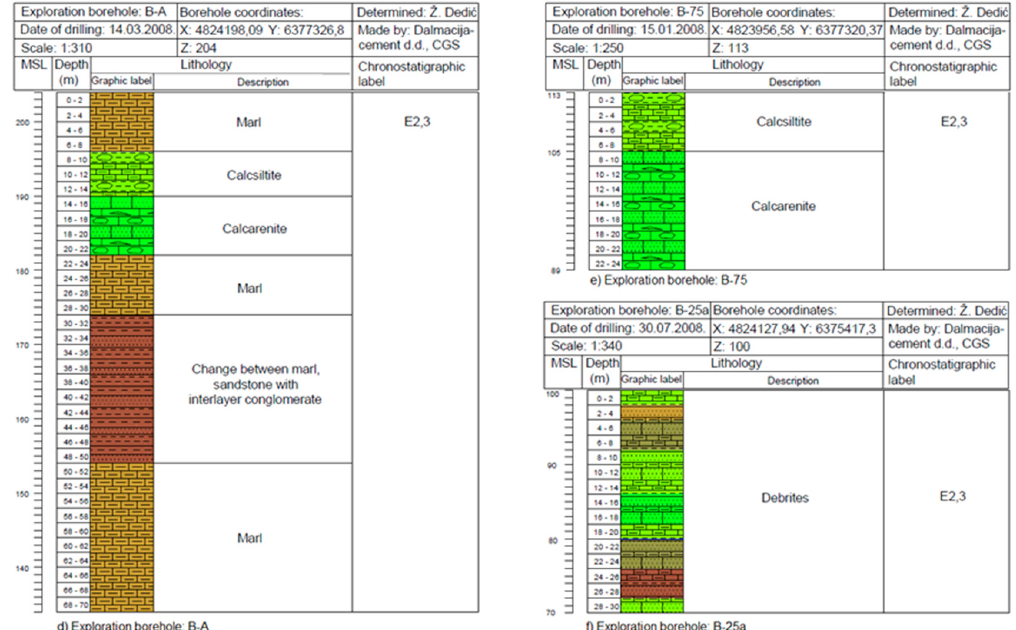
Figure 3. Geological sections: ( a ) exploration borehole B-45: lithological unit marls and sandstones with alterations of conglomerates; ( b ) exploration borehole B-10: lithological unit clayey marl; ( c ) exploration borehole B-G: lithological unit marl; ( d ) exploration borehole B-A: lithological unit calcsiltite; ( e ) exploration borehole B-75: lithological unit calcarenite; ( f ) exploration borehole B-25a: lithological unit debrites.